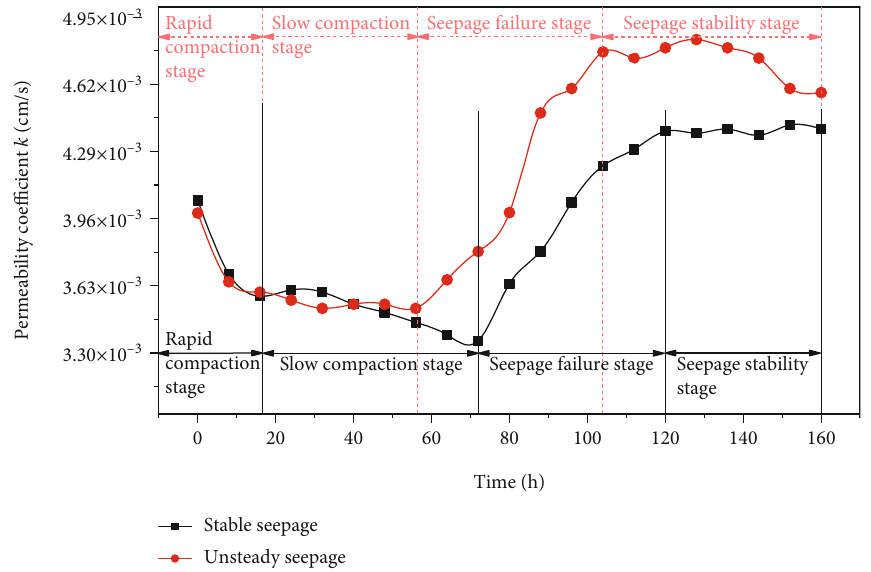
Figure 8: Comparison between unsteady seepage and stable